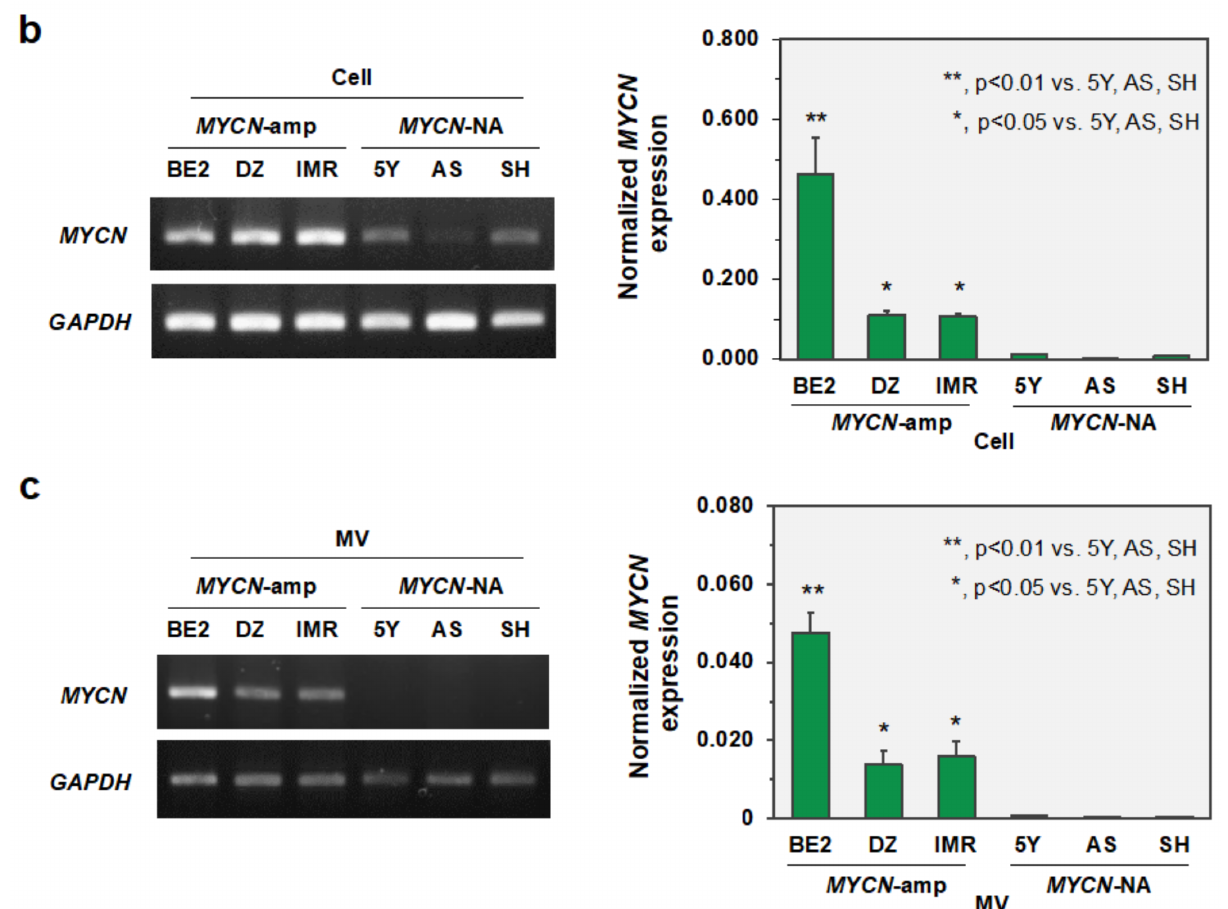
Figure 2. Detection of MYCN amplification status of six NB cell lines and their MVs. ( a ) Fluorescent in-situ hybridization (FISH) using the DNA probes for MYCN (2p24; green) and CEP2 (2p11.1-q11.1; orange). Quantitative RT-PCR was performed to detect MYCN mRNA in ( b ) six neuroblastoma cell lines and ( c ) their corresponding MV isolates. The PCR products were validated on agarose gel electrophoresis. MYCN mRNA expression level was normalized to GAPDH. Abbreviations: 5Y, SH-SY5Y; AS, SK-N-AS; BE2, SK-N-BE2; DZ, SK-N-DZ; IMR, IMR-32; MV, microvesicles; MYCN-amp, MYCN amplification; MYCN-NA, MYCN non-amplification; SH,